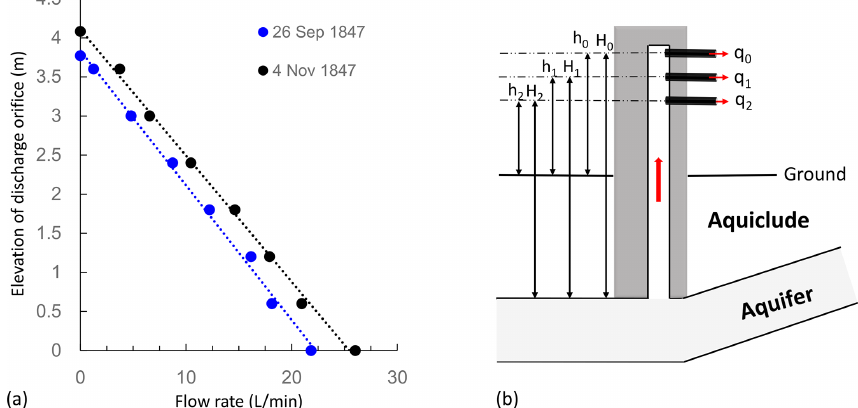
Figure 4. (a) The changes in flow rate with elevation of discharge orifice of a flowing well (data from Darcy, 1856); (b) the device for measuring flow rate (only one discharge orifice is open during measurement). The higher flow rate in November shown in (a) can be a result of higher hydraulic head surrounding the flowing well, probably due to the contribution of groundwater